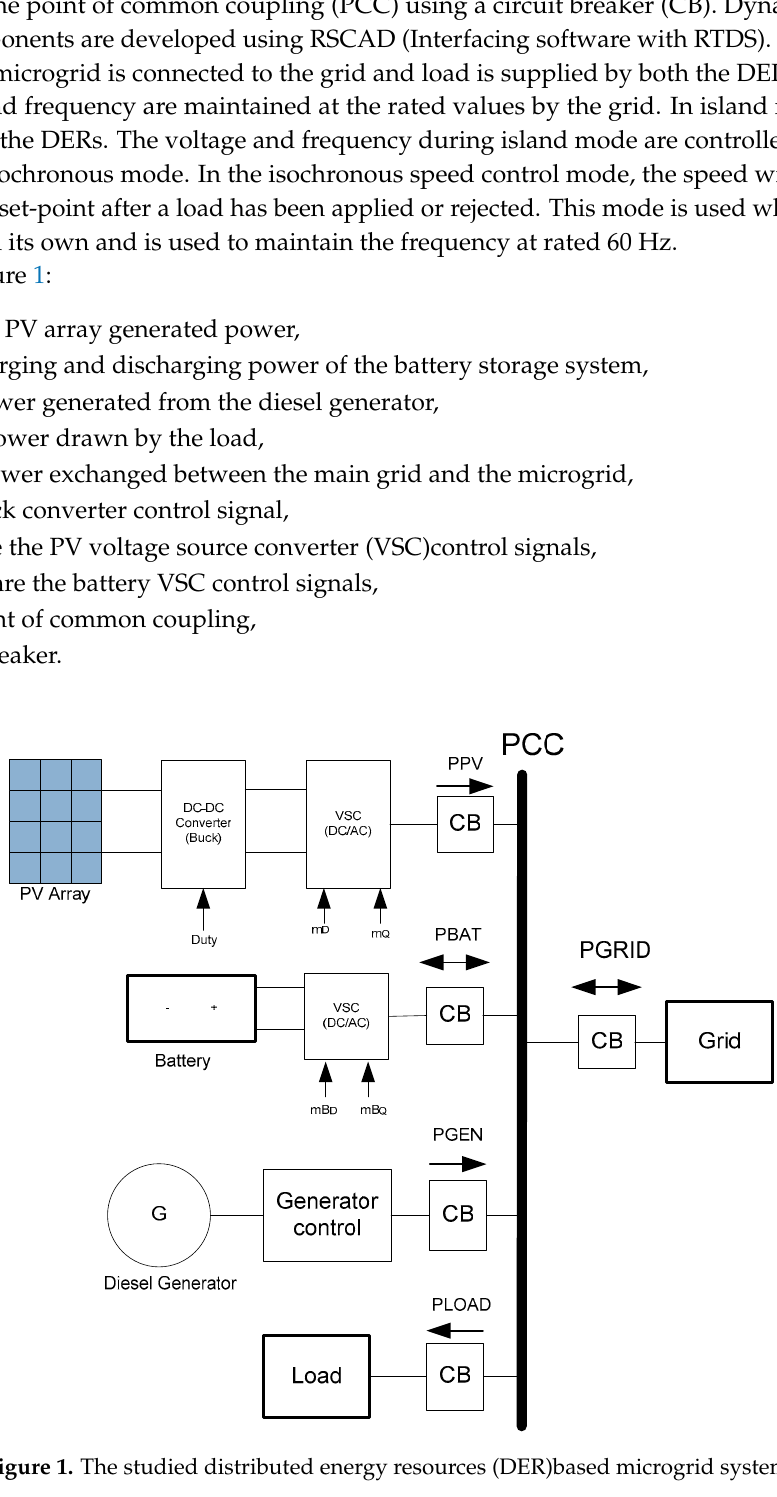
Figure 1. The studied distributed energy resources (DER)based microgrid system.